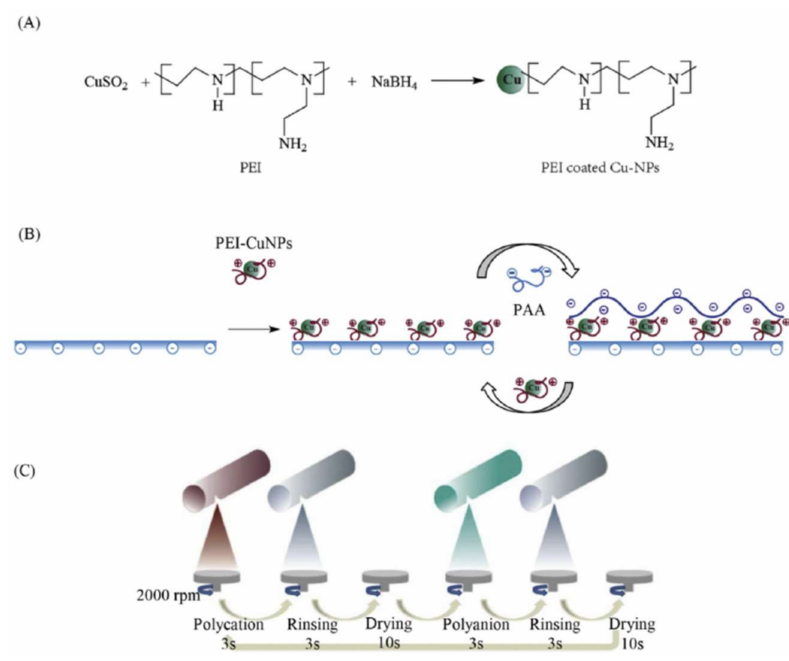
Figure 13. Schemes of: ( A ) preparation of PEI-coated Cu-NPs; ( B ) coating Cu-NPs on the membrane surface via the layer-by-layer self-assembly method; and ( C ) spray- and spin-assisted layer-by-layer (SSLBL) self-assembly process, adapted from Ma et al.